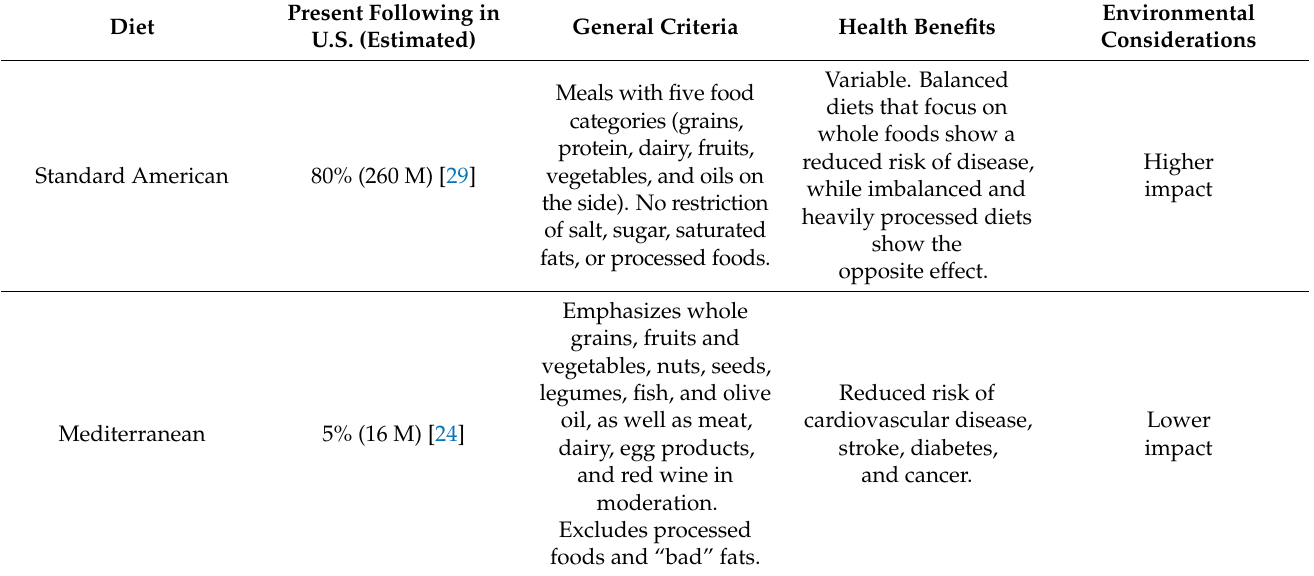
Table 1. Summary of Diet